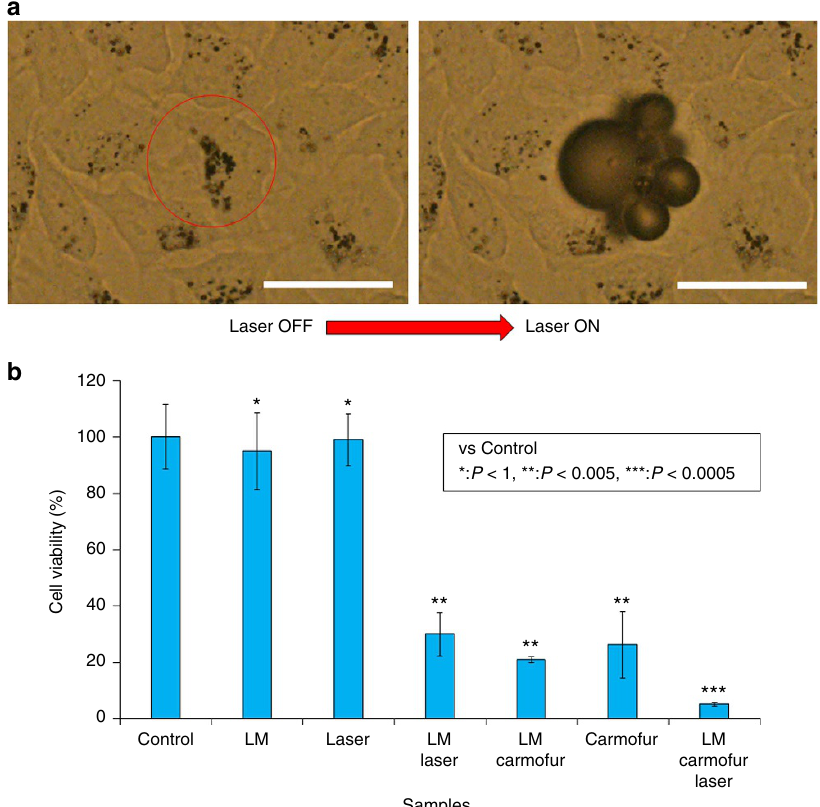
Figure 7 | Cancer cell elimination by laser-induced LM nanocapsules. ( a ) Real-time elimination of HeLa cells caused by laser-induced LM nanocapsules before and after laser irradiation (808nm, 564mW, B 287 m W m m (cid:2) 2 ). The red circle shows laser irradiation position and area. Scale bars, 50 m m. ( b ) Multi-dimensional cancer cell elimination using the indicated physicochemical treatments (785nm, 1W, B 80mWmm (cid:2) 2 ). Error bars represent s.d.’s of three separate measurements. * P o 1; ** P o 0.005; *** P o